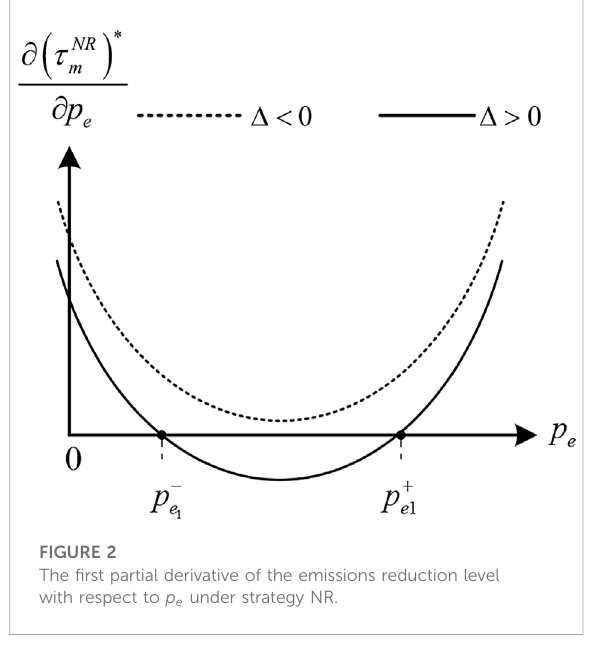
FIGURE 2 The fi rst partial derivative of the emissions reduction level with respect to p e under strategy NR.